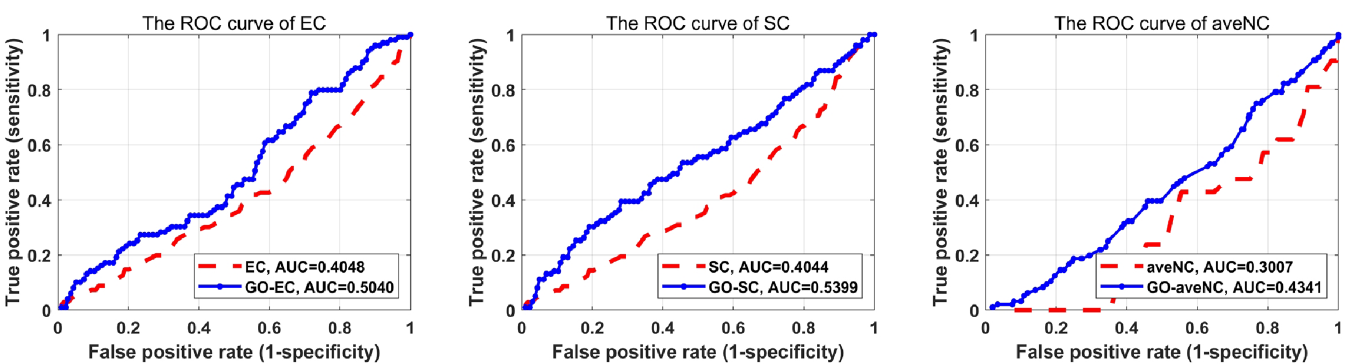
Fig 4. The comparison of ROC curves for original new DIP PPI network and Wang-BP (the Wang method under the BP subontology) PPI network under (left) EC method, (middle) SC method and (right) aveNC method.